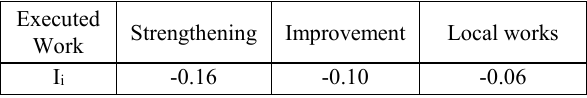
Table 2. Indices of executed works I i .